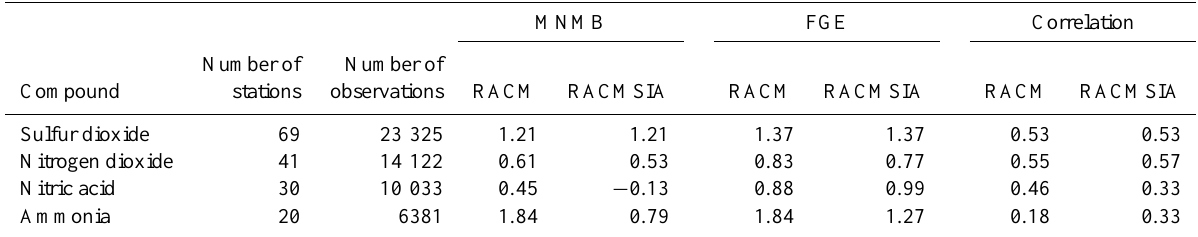
Table 9. Gaseous compound statistics of simulation results against daily HTAP observations. Comparison between a simulation with SIA (RACMSIA) and without SIA formation (RACM).